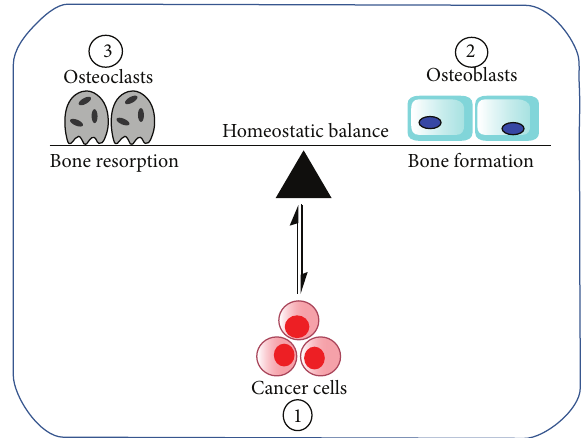
Figure 1: Schematic of lung cancer invasion of bone microen- vironment resulting in disruption of normal bone homoeostasis. The invading tumor cells (1) primarily influence the functions of osteoclasts (2) and osteoblasts (3) that are involved in regulating bone